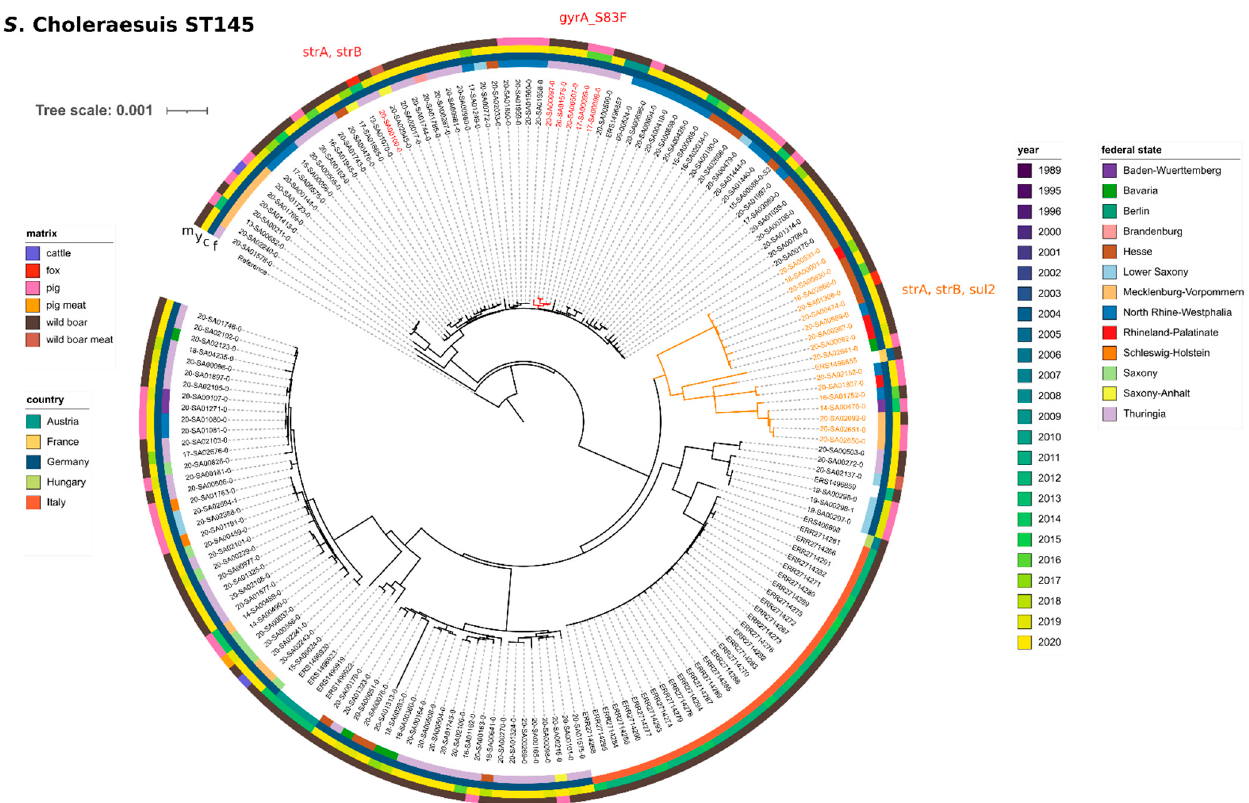
Figure 3. Phylogenetic relationship between S. Choleraesuis (ST145) wildlife isolates and isolates from food, feed and farm animals. Maximum likelihood phylogenetic tree based on core SNPs in the bacterial chromosome. The chromosome sequence of S. Choleraesuis str. SCSA50 isolate A50 (NZ_CM001062.1) was used as reference. The tree was computed with the snippySnake pipeline with IQ-TREE, visualized in iTOL and manually rooted to the reference. The colour bars (inside to outside) identify the German federal state (f), national country (c), sampling year (y) and matrix (m) of the samples. Isolates carrying antimicrobial resistance genes are highlighted in colour with the type of resistance genes indicated. The scale bar shows the genomic distances of the sequences in substitutions per site.